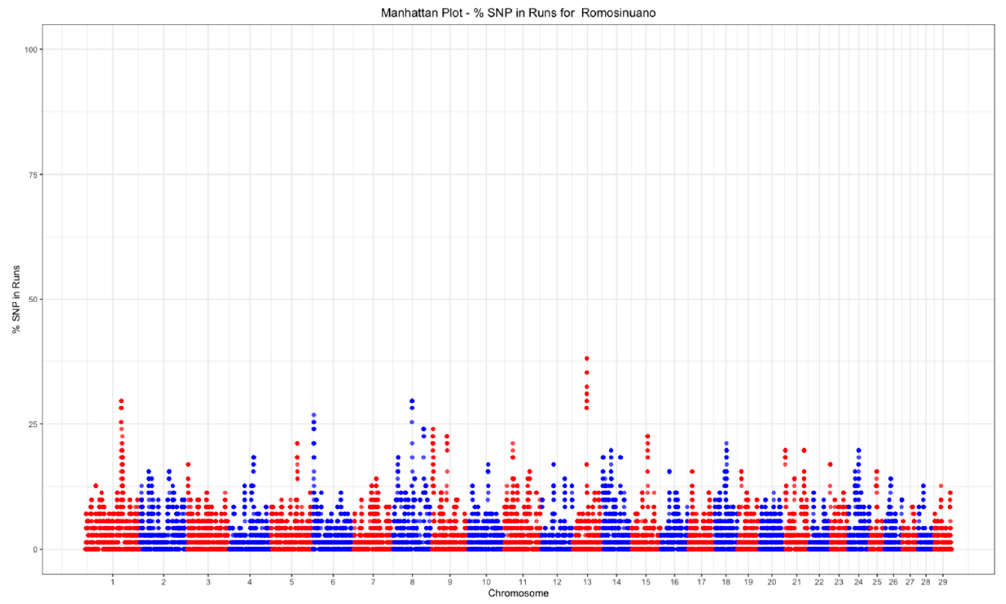
Figure 7. Manhattan plot of the SNP frequency within runs of heterozygosity by autosome in the Mexican Romosinuano beef cattle population.